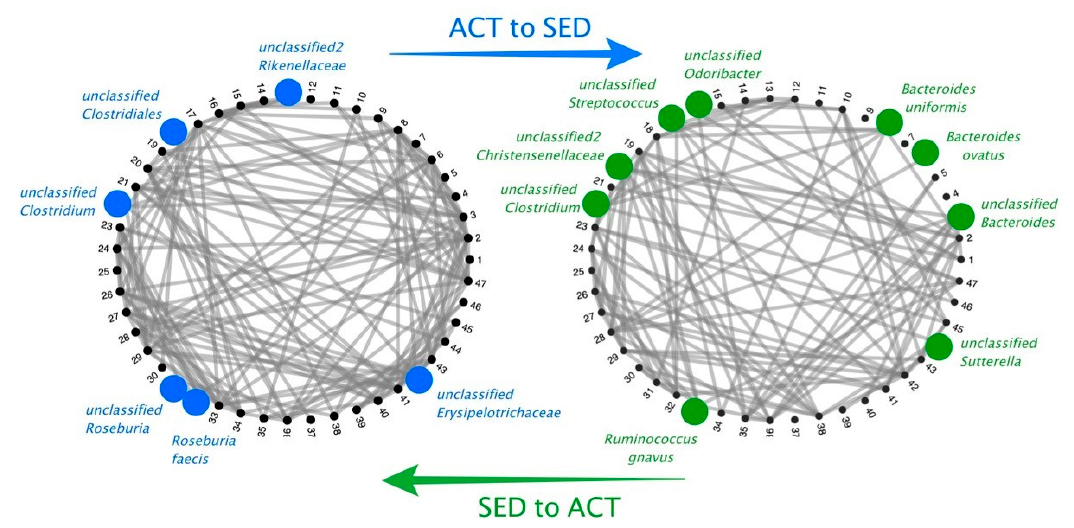
Figure 2. Network transition between ACT (blue) and SED (green) conditions, with the statistically significant ( p < 0.001) driving keystone bacteria (represented by circles).